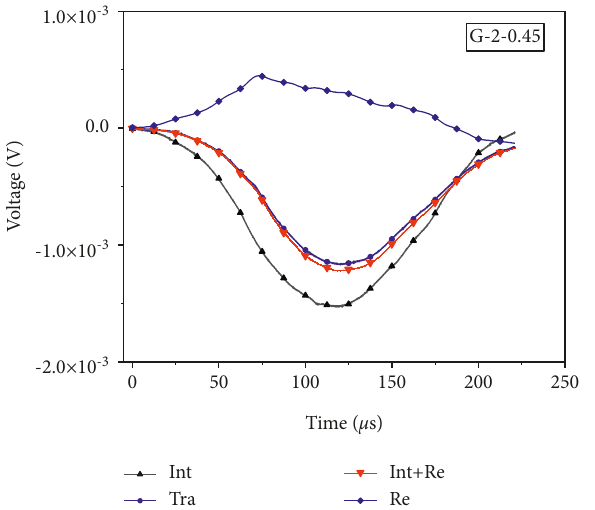
5: Energy evolution of the granite sample